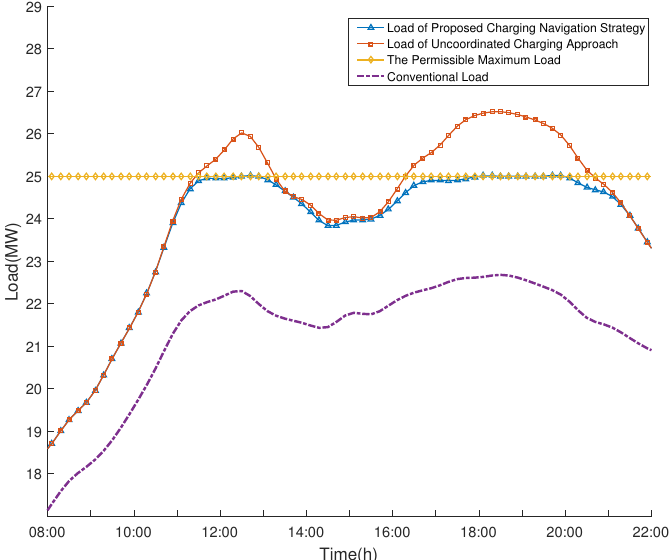
Figure 9. Comparison of load curves to demonstrate the impacts of Electric vehicle (EV) charging